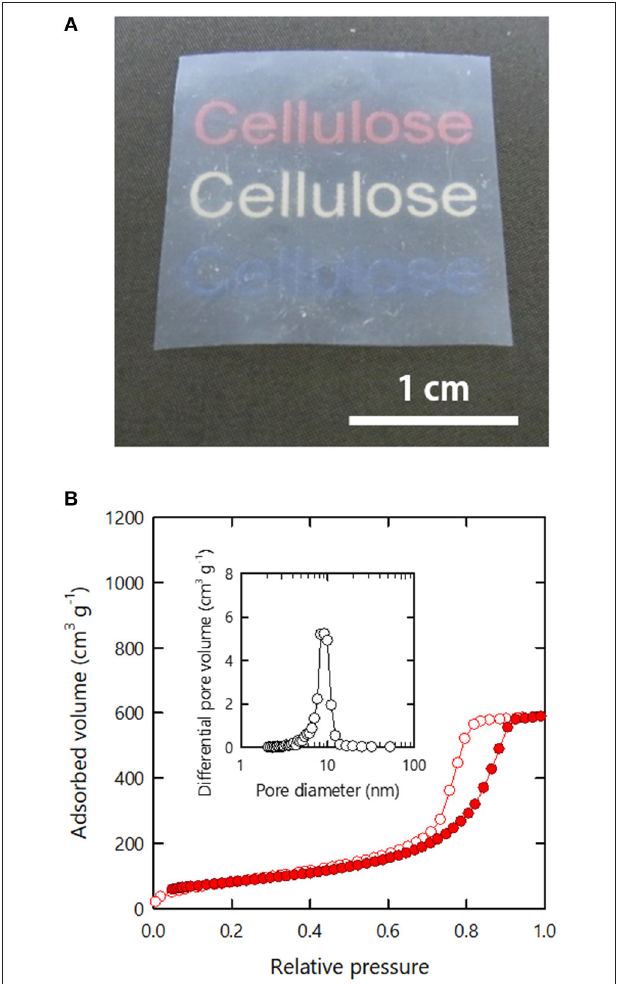
FIGURE 6 | (A) Appearance and (B) nitrogen adsorption–desorption isotherm of the membranous h - Al -xerogel. Inset in (B) shows the pore size distribution estimated from the